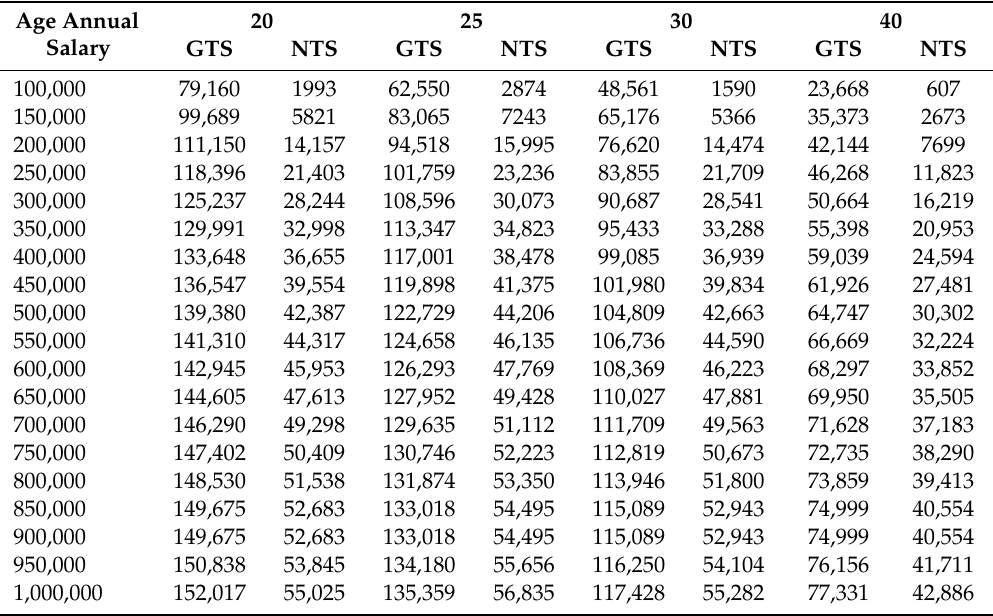
Table 2. The GTS and NTS of di ff erent initial insured annual salaries for women under di ff erent initial insured ages. (unit: